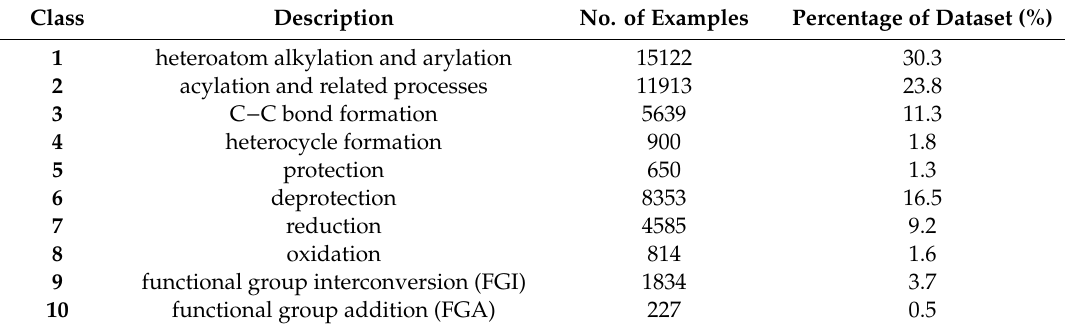
Table 1. Distribution and description of the major reaction classes within the processed reaction dataset